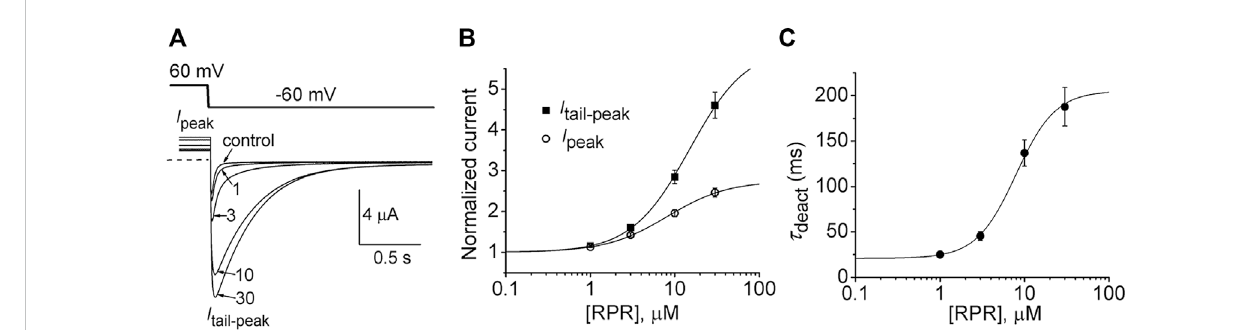
FIGURE 1 RPR activates split hERG1a channel currents. (A) Voltage clamp protocol and corresponding split hERG1a currents recorded from an oocyte before (control) andafter treatmentwithindicatedconcentrations(inµM)ofRPR.Oocytewasbathedinasolutioncontaining104 mMKCl. Dottedlineindicates zerocurrentlevel. (B) Concentration-responserelationshipfortheeffectsofRPRon I tail-peak (EC 50 =15.0±1.9 µM, n H =1.3±0.04, n =7)and I peak (EC 50 = 8.2 ± 1.0 µM, n H = 1.2 ± 0.06, n = 7). (C) Concentration-response relationship for the effects of RPR on τ deact measured at − 60 mV (EC 50 = 7.9 ± 1.0 µM, n H = 1.9 ± 0.1, n = 5).